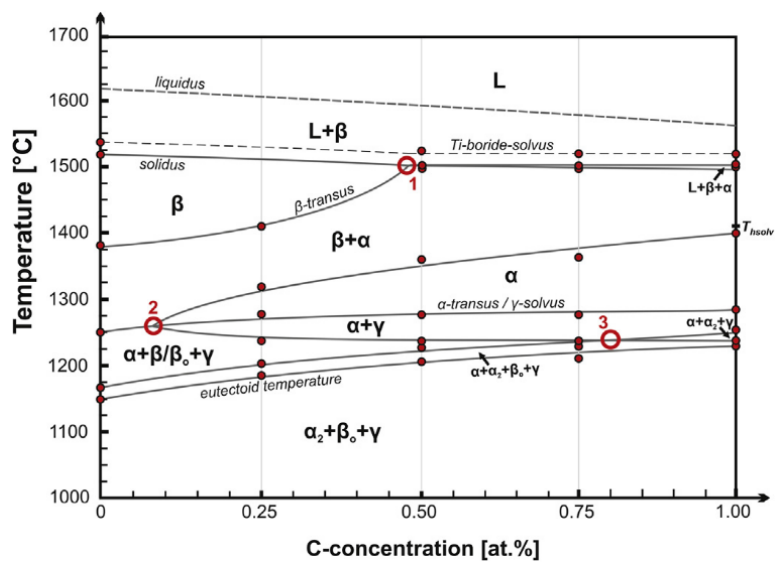
Figure 6. Volume fraction of γ - phase, α -phase, and β -phase at different temperatures.